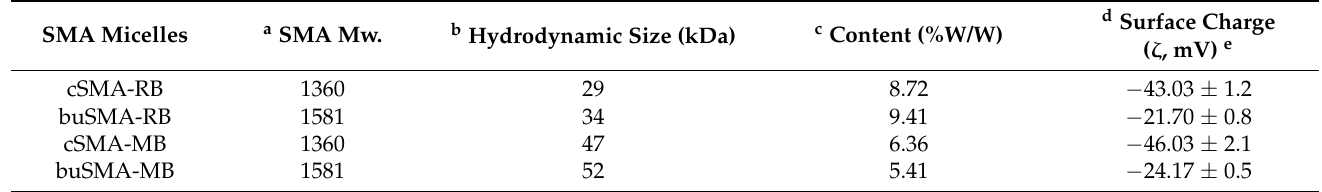
Table 1. Properties and characterization of the Polystyrene-co-maleic acid-Photosensitizers (SMA- PSs)